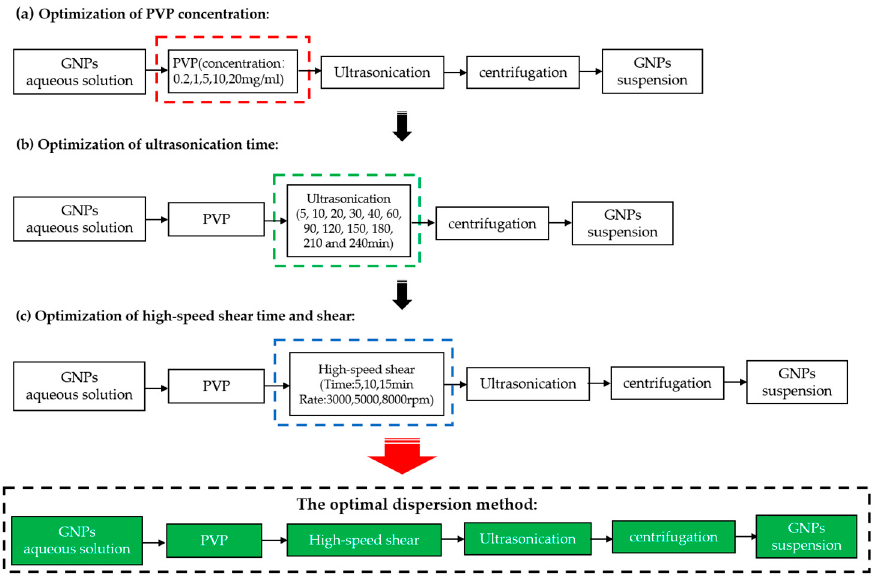
Figure 1. Flowchart of optimal dispersion parameter. ( a ) Optimization of PVP concentration; ( b ) Optimization of ultrasonication time; ( c ) Optimization of high-speed shear time and rate.